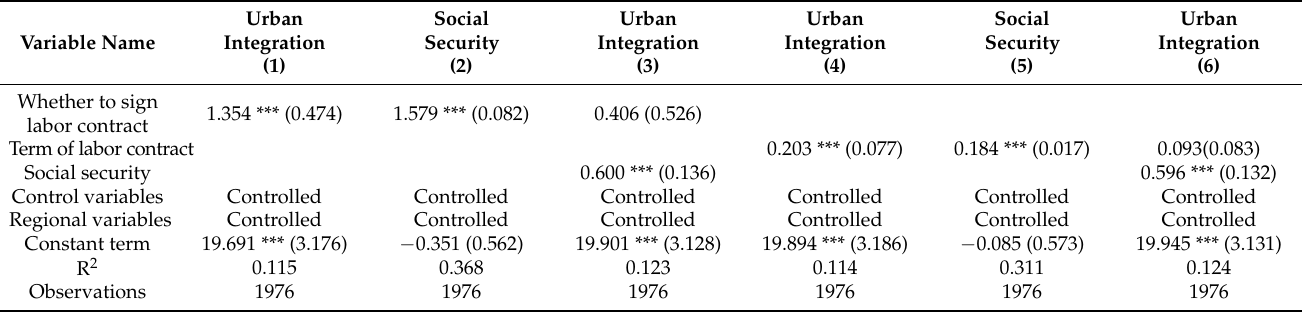
Table 6. Test of the mediating effect of labor contract and urban integration of migrant workers.